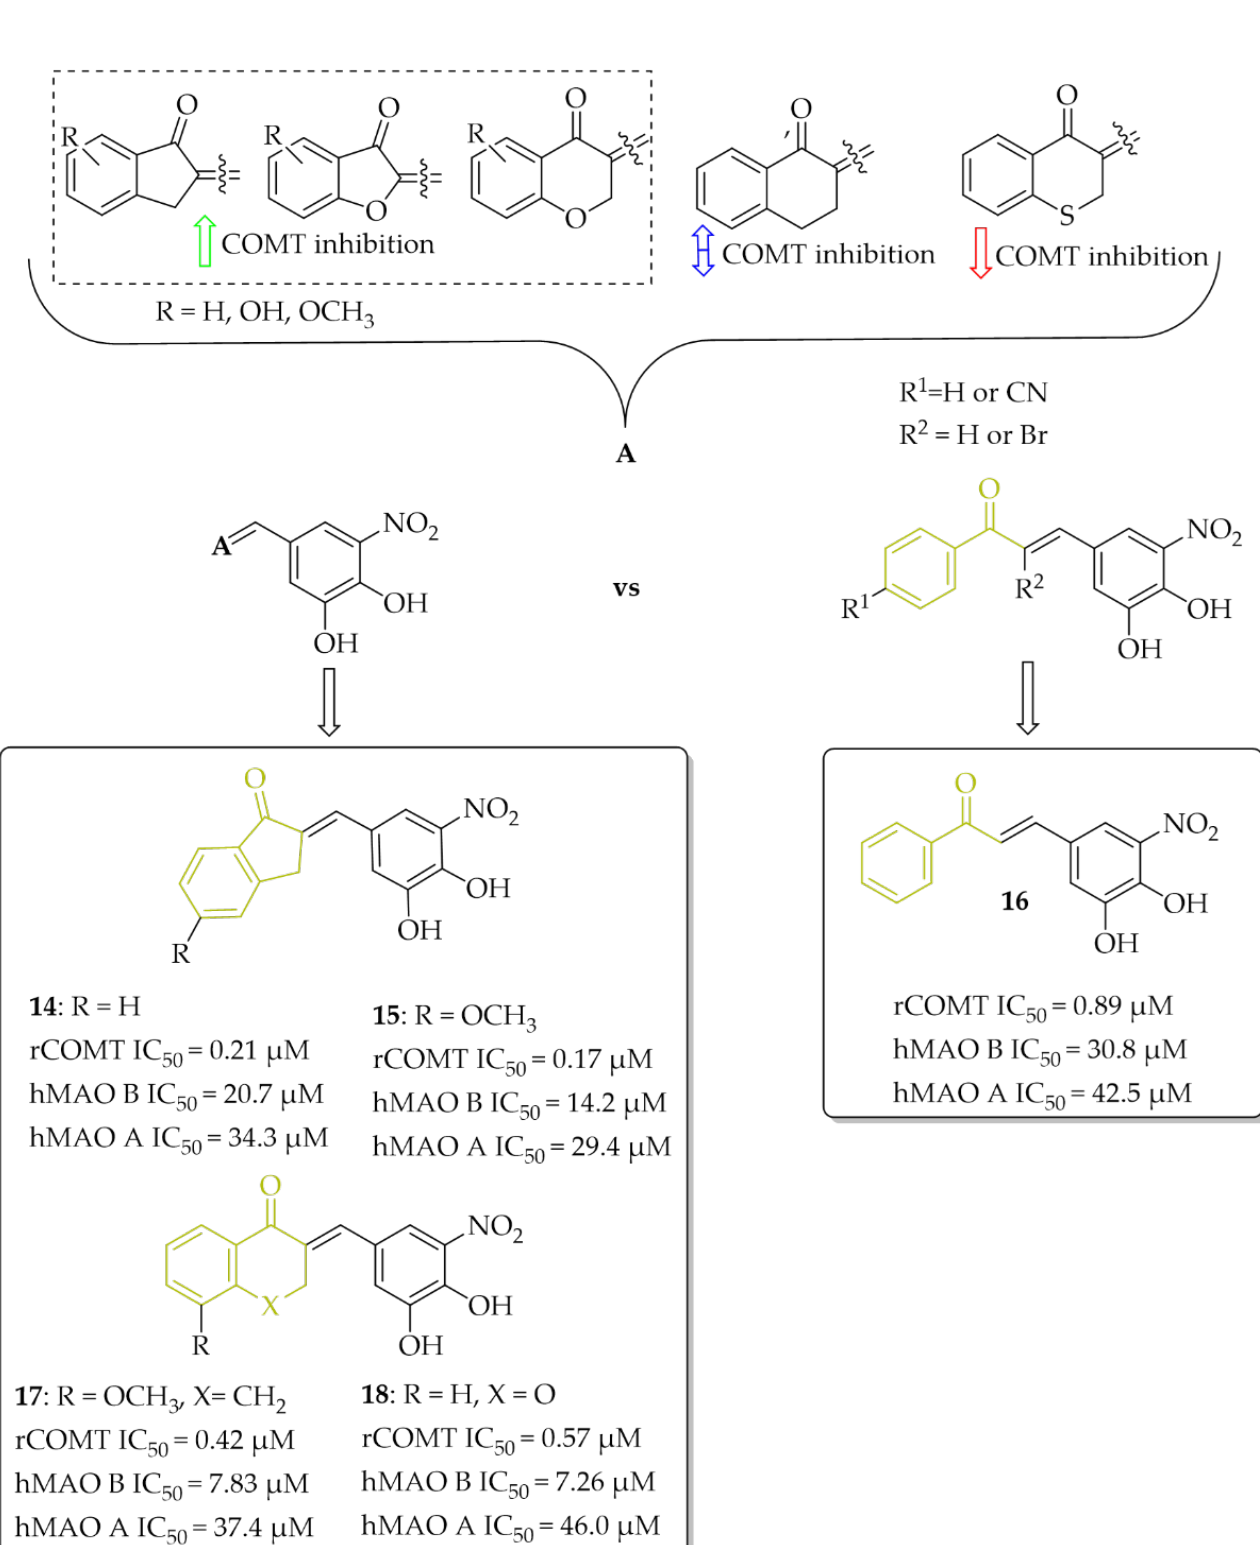
Figure 14. Dual COMT and MAO B inhibitors synthesised by de Beer et al. and the most potent compounds in this series [37].